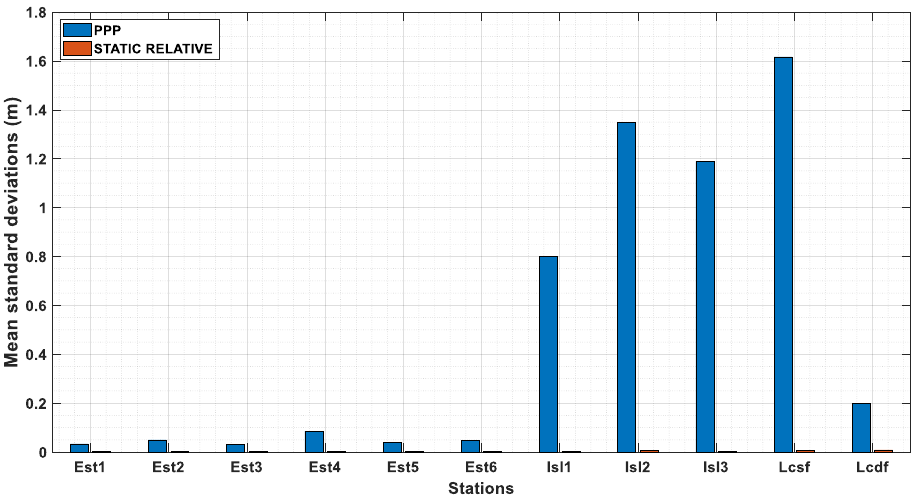
Figure 12. Mean standard deviation in the static relative method and PPP. Table 9. Absolute difference between the PPP and the static relative methods in